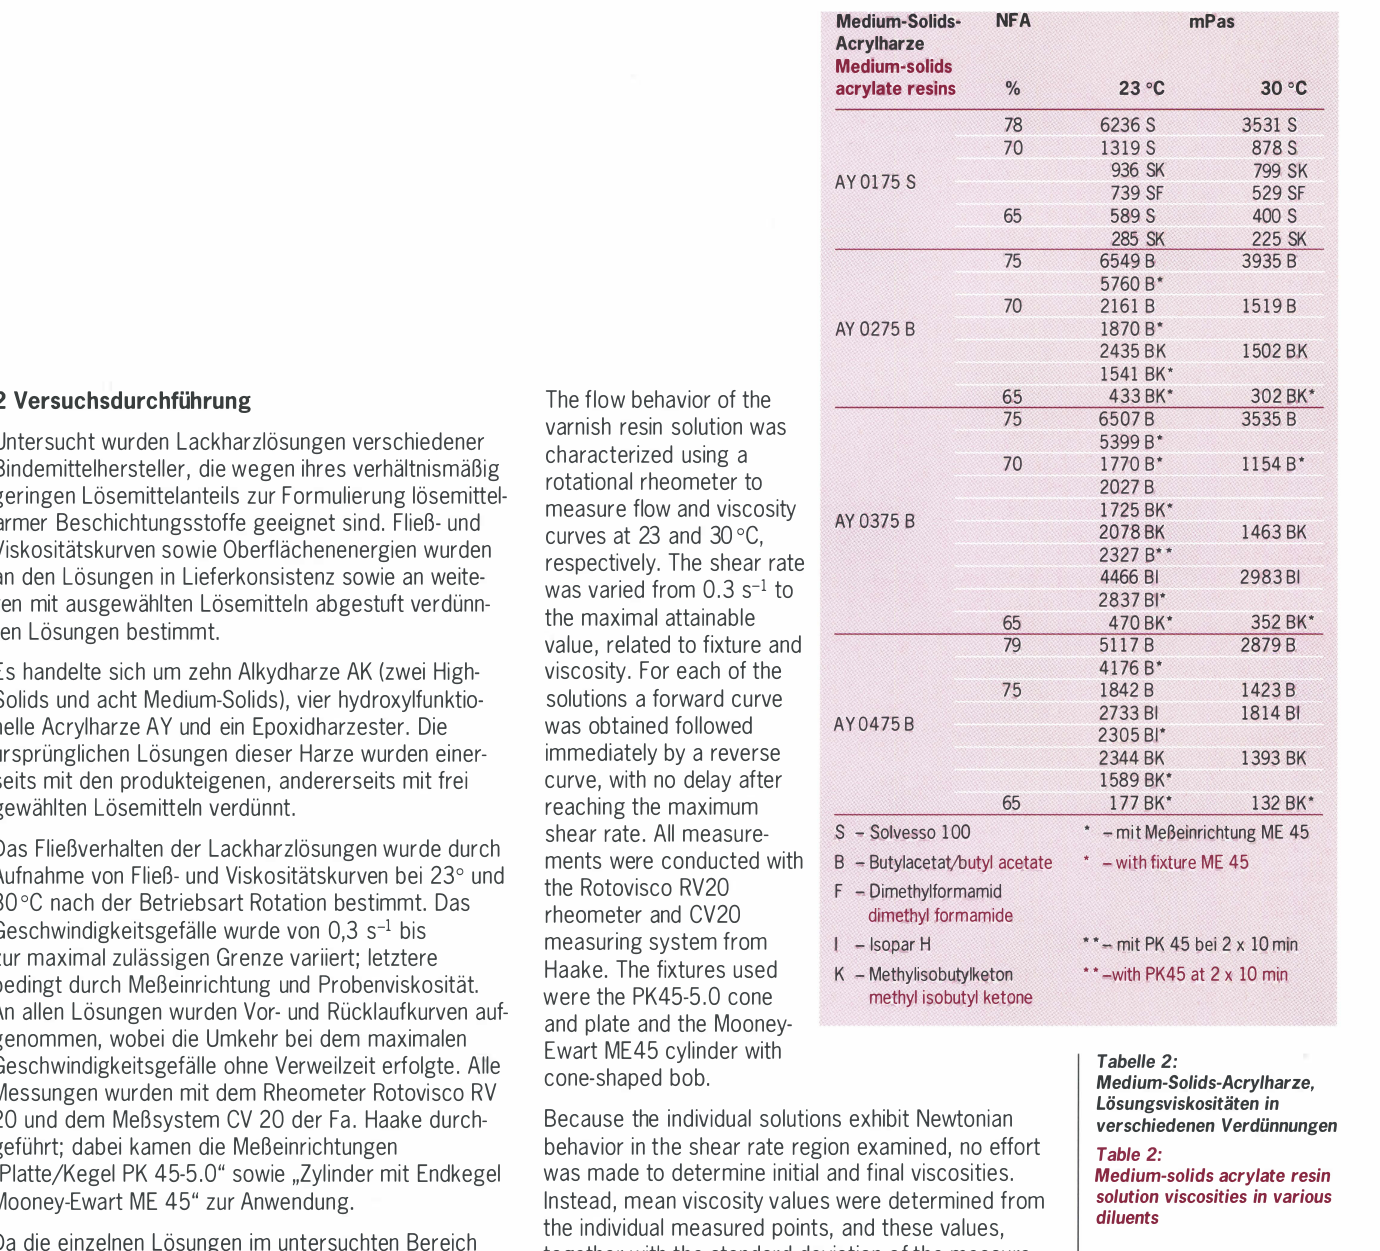
Table 2: Medium-so/ids acrylate resin solution viscosities in various